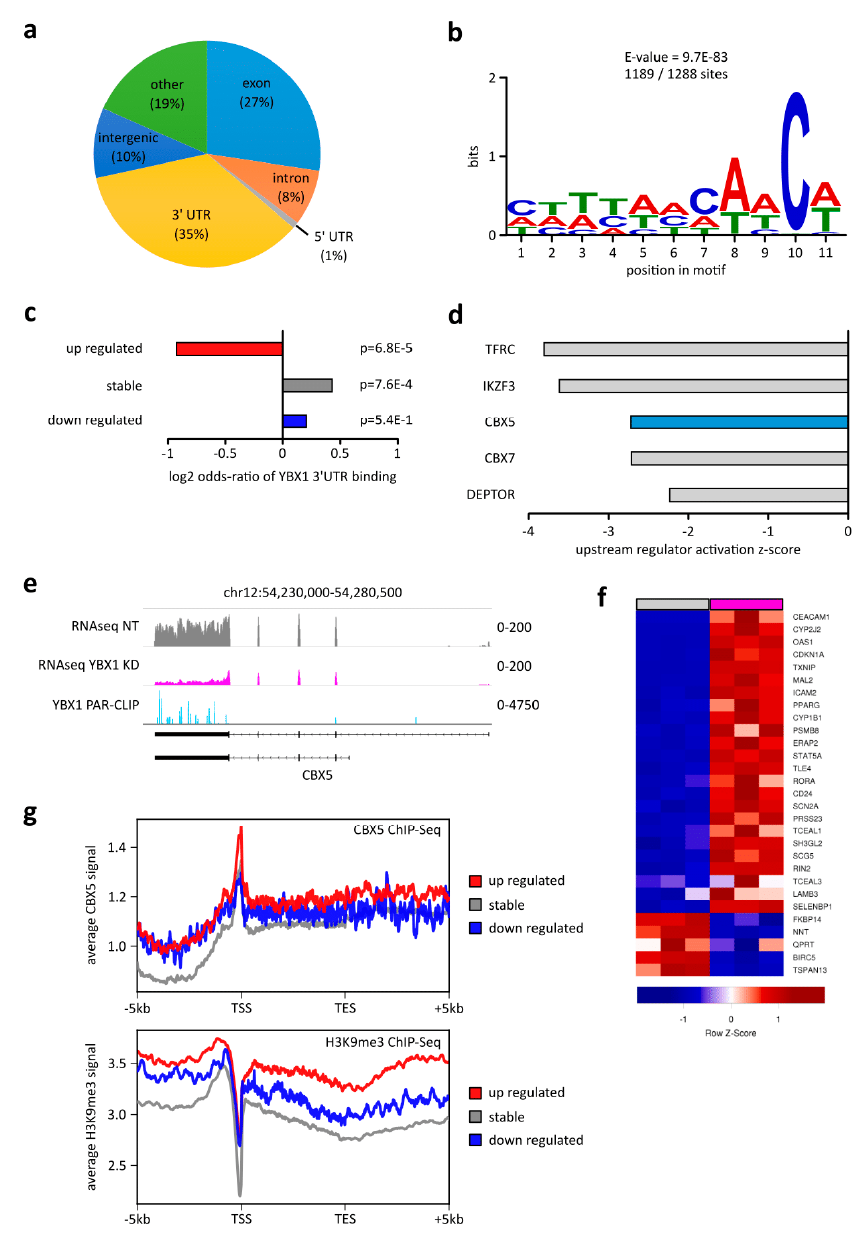
ff ects repression of inflammatory pathway